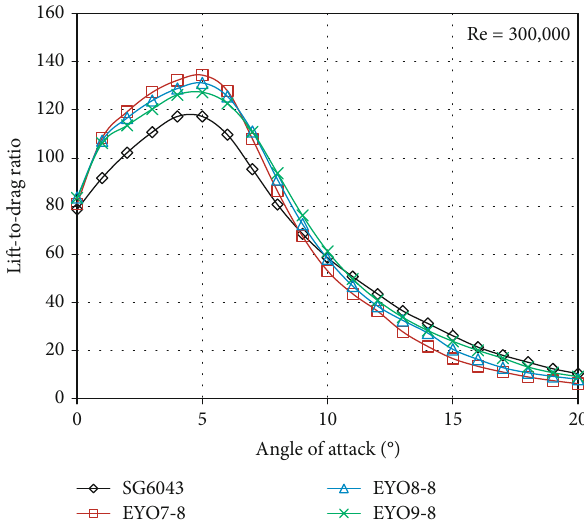
Figure 4: Lift performances of SG6043 and EYO-Series airfoils at Re = 300,000 .